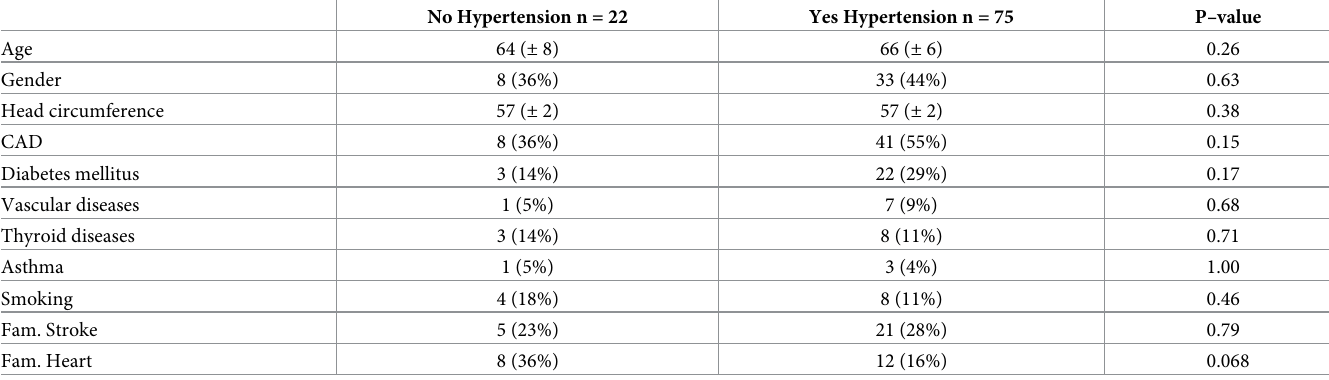
Table 1. Baseline